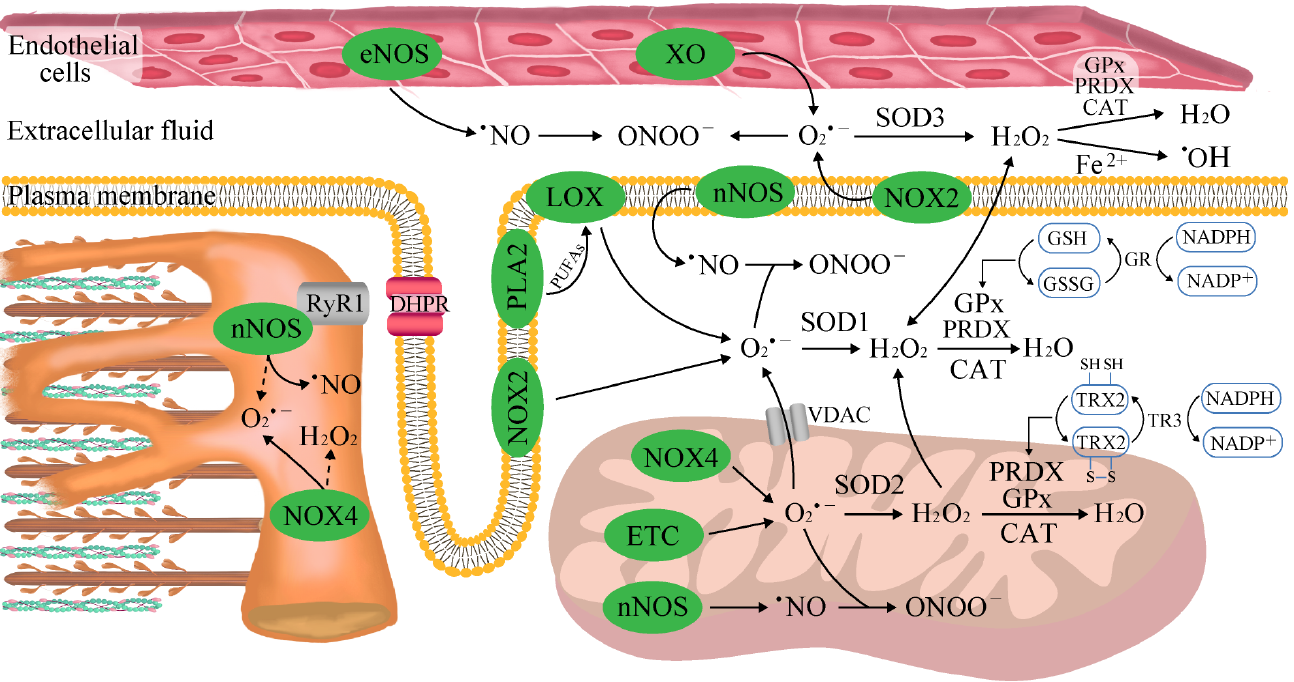
Figure 1. Overview of the major oxidant and antioxidant systems in skeletal muscle. Mitochondrial respiration shifts from state 4 to active state 3 when muscle contractions start, which is characterized by a lower superoxide (O 2 •− ) production than at rest. NADPH oxidase (NOX) enzymes become activated in response to sarcolemma depolarization, ATP release, and fiber stretching associated with exercise. NOX2 resides in the plasma membrane and transverse tubules, and it is the main source for cytosolic O 2 •− generation in contracting muscle. NOX4 was reported to localize in the sarcoplasmic reticulum and mitochondrial intermembrane space. Xanthine oxidase (XO) is abundant in endothelial cells and activates via increases in shear stresses applied to skeletal muscle and ATP hydrolysis. The release of polyunsaturated fatty acids (PUFAs) from plasma membrane is stimulated by phospholipase A 2 (PLA 2 ), and the released free PUFAs are subsequently oxidized by lipoxygenase (LOX). The formed O 2 •− is detoxified with the assistance of superoxide dismutase (SOD), catalase (CAT), glutathione peroxidase (GPx), peroxiredoxin (PRDX) or thioredoxin (TRX). The PRDX-mediated reduction in H 2 O 2 uses TRX as the electron donor. In the course of the reaction, one sulfhydryl group of the cysteine residues in PRDX is oxidized and a disulfide bridge is formed. Then, the disulfide bridge is reduced by TRX at the expense of NADPH oxidation. Abbreviations: DHPR, dihydropyridine receptor; ETC, mitochondrial electron transport chain; GR, glutathione reductase; RyR1, ryanodine receptor 1; TR3, thioredoxin reductase 3; VDAC, voltage-dependent anion channel. Endogenous thiol antioxidants glutathione (GSH), thioredoxin (TRX) and